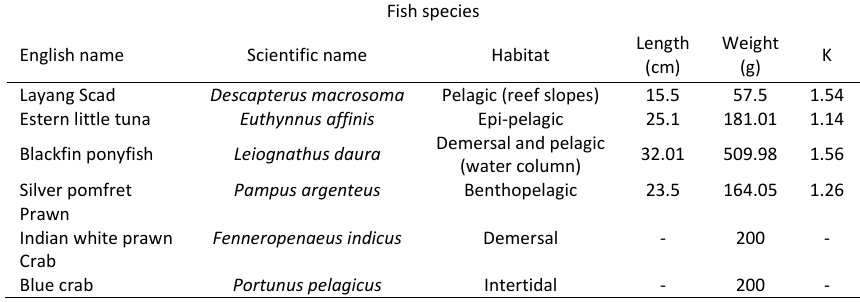
Table 1: List of fish, prawn and crab species with length, weight and Fulton’s condition factor (K) along with ecological characteristics Fish species